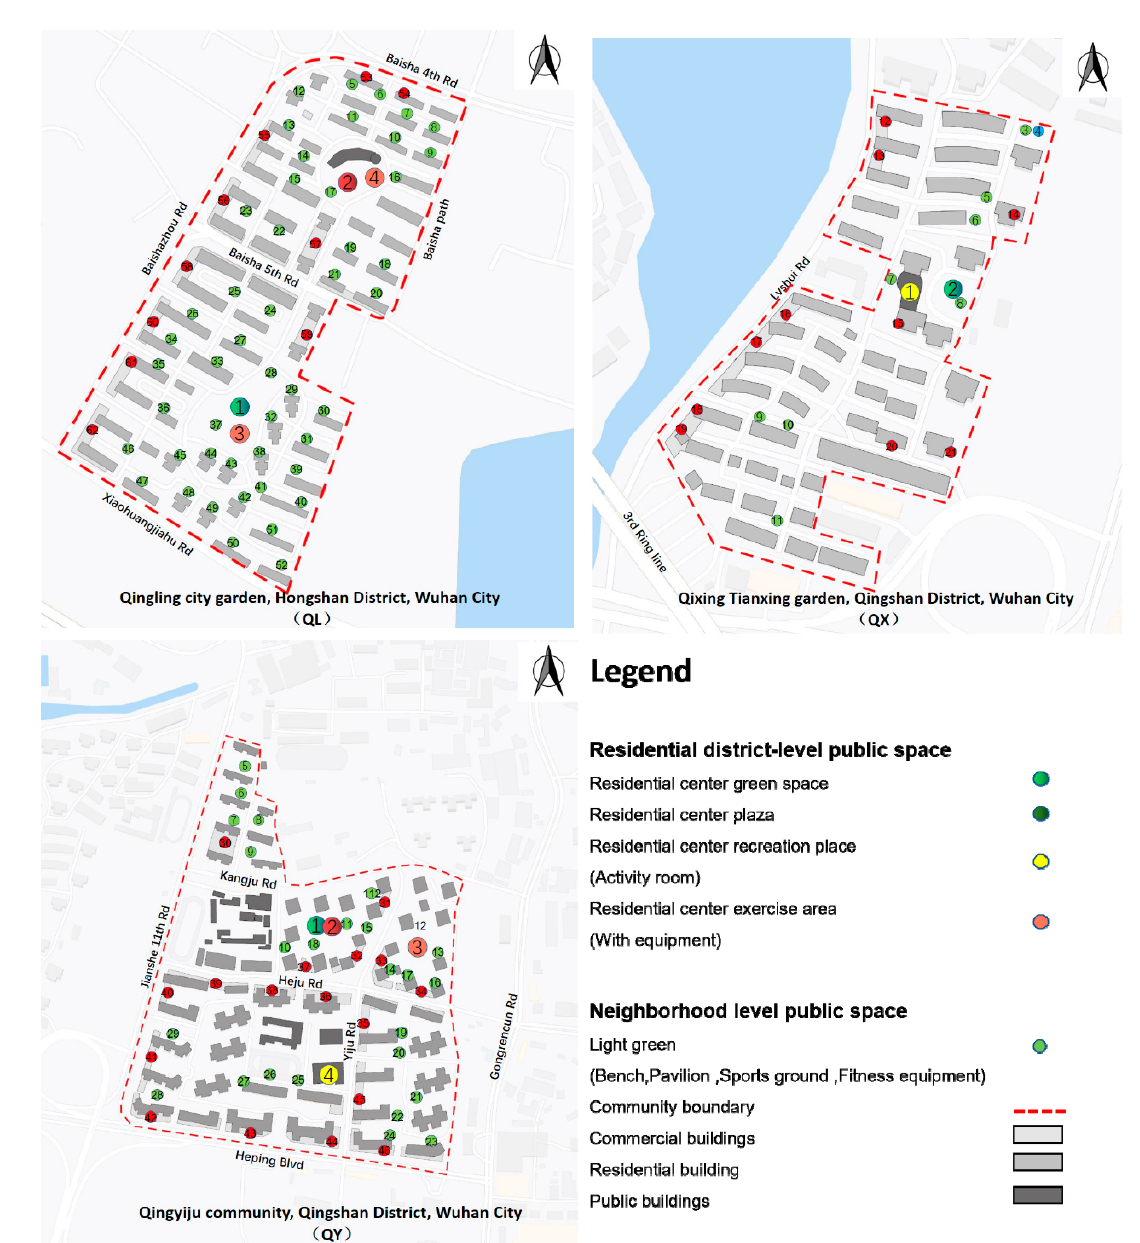
Figure 3. Numbering of public space node in the Qingling City Garden, Qiyiju and Qixing Tianxing Garden.